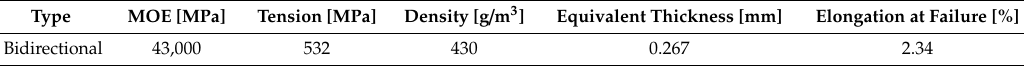
Table 2. Properties of flax fabric impregnated with